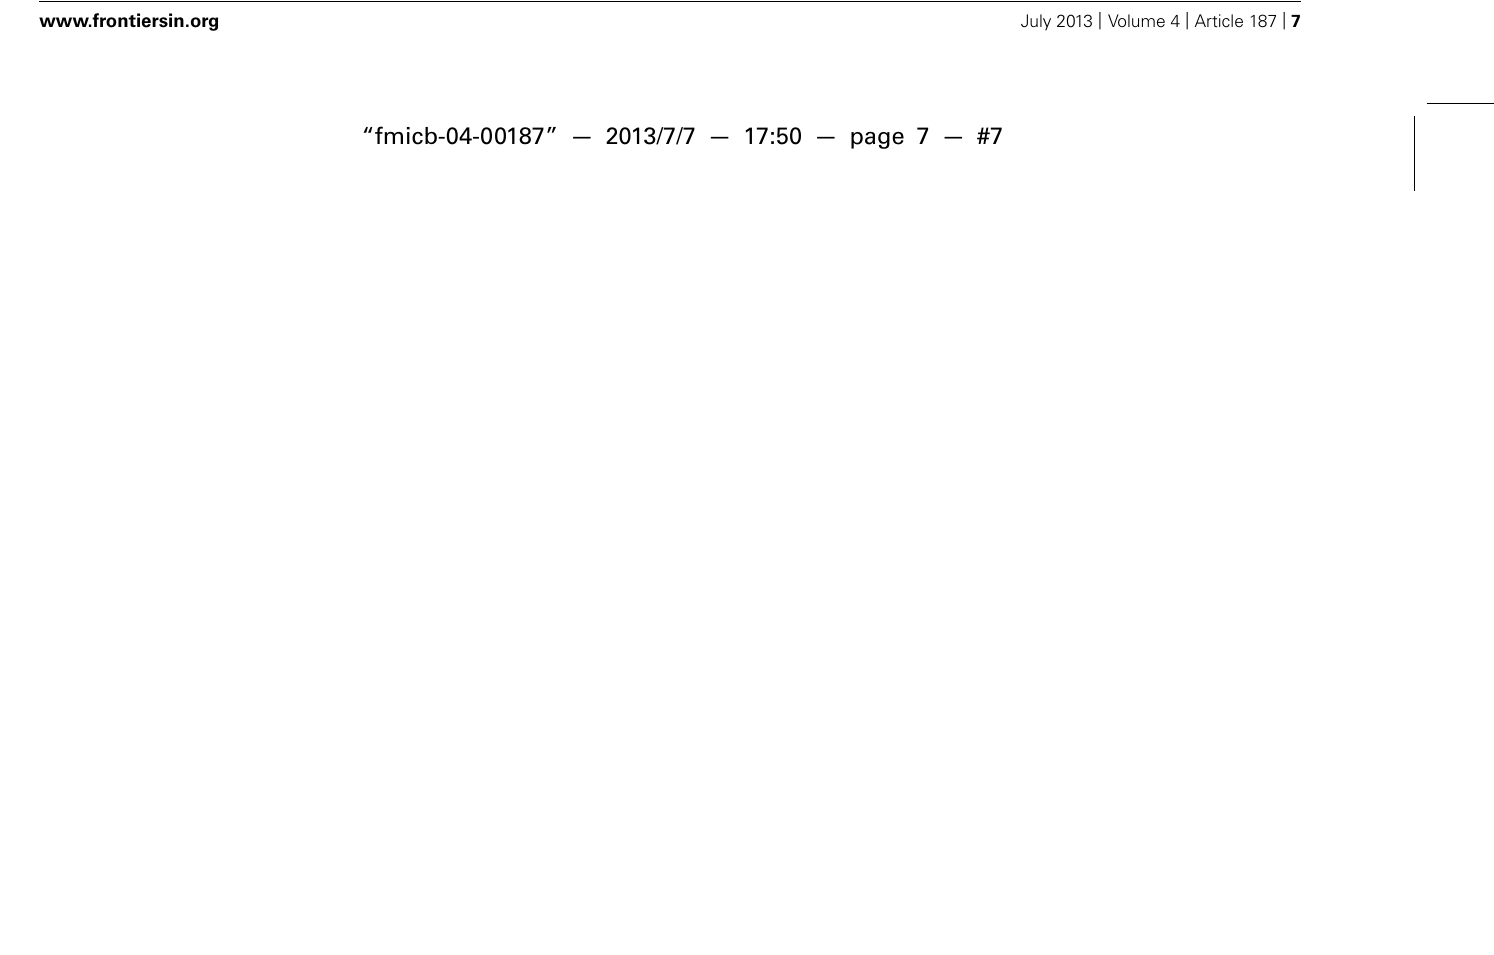
FIGURE 1 | Structure of HIV-1mt clones. Blue boxes denote HIV-1 NL4-3 -derived sequences and red boxes denote SIVmac239- derived sequences, respectively. Orange arrows show adaptive mutations that enhance viral growth potential in macaqueT cell